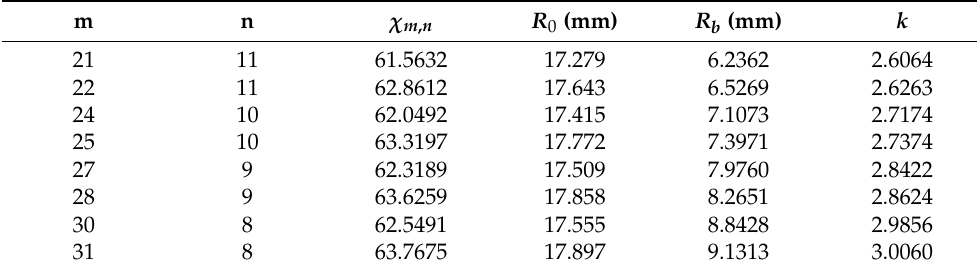
Table 2. Characteristics of probable operating modes for 170 GHz